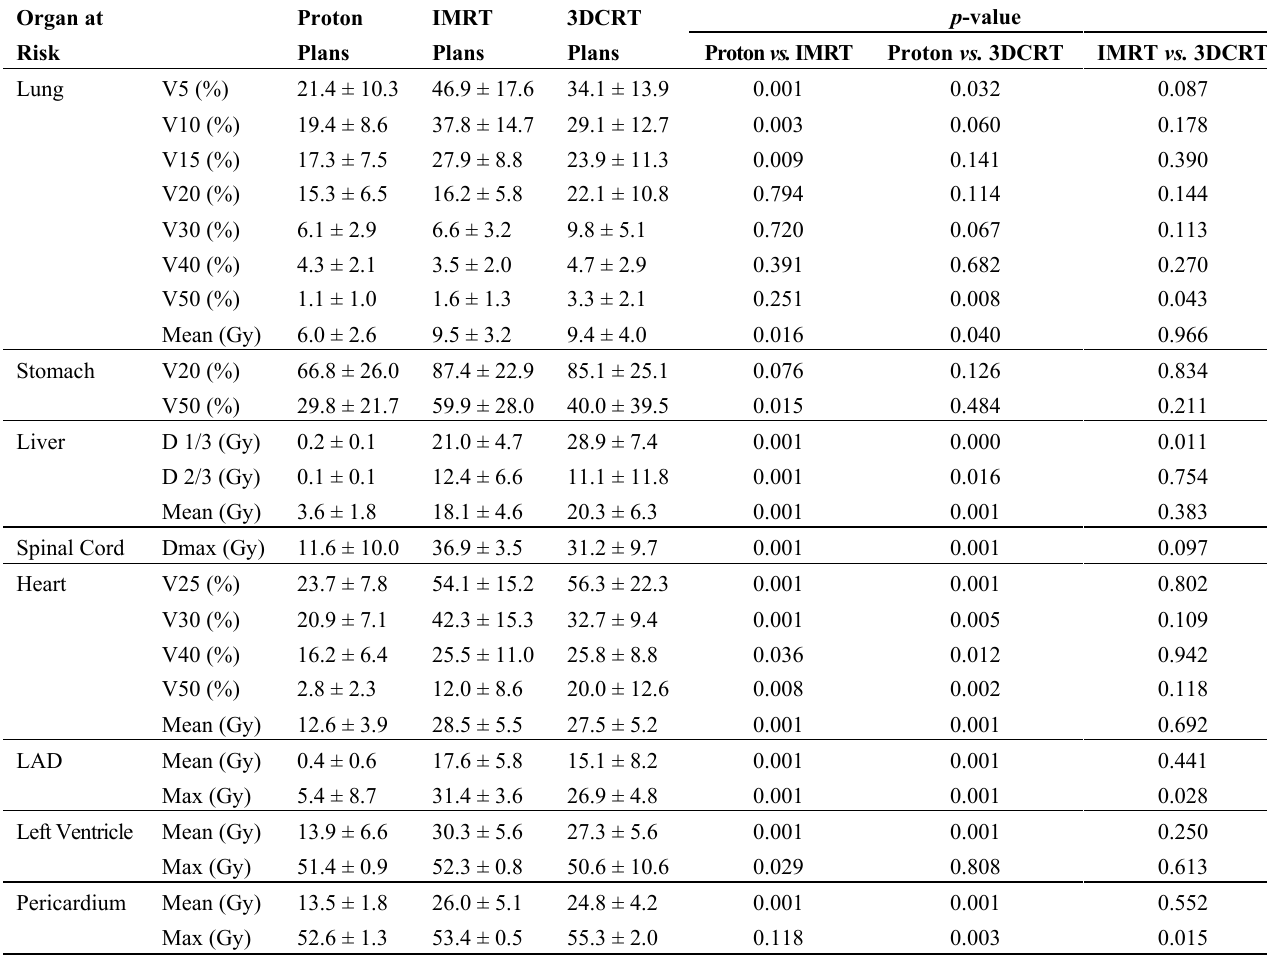
Table 2. Averaged over 10 patients DVH parameters (±SD) with p -values for